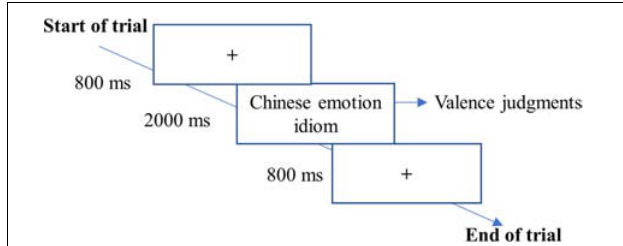
FIGURE 1 | A trial used in Experiment 1.